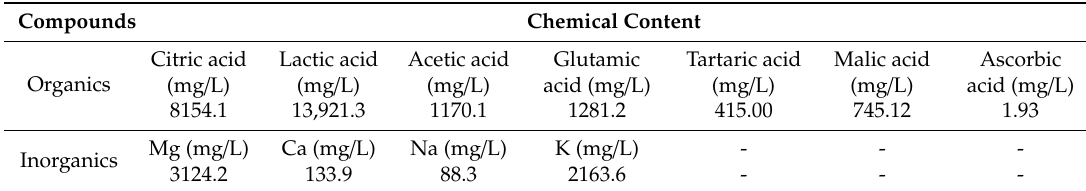
Table 4. Detectable chemical contents in cucumber extract fermented by Lactobacillus paracasei KCTC 13169 using HMC as the neutralizing